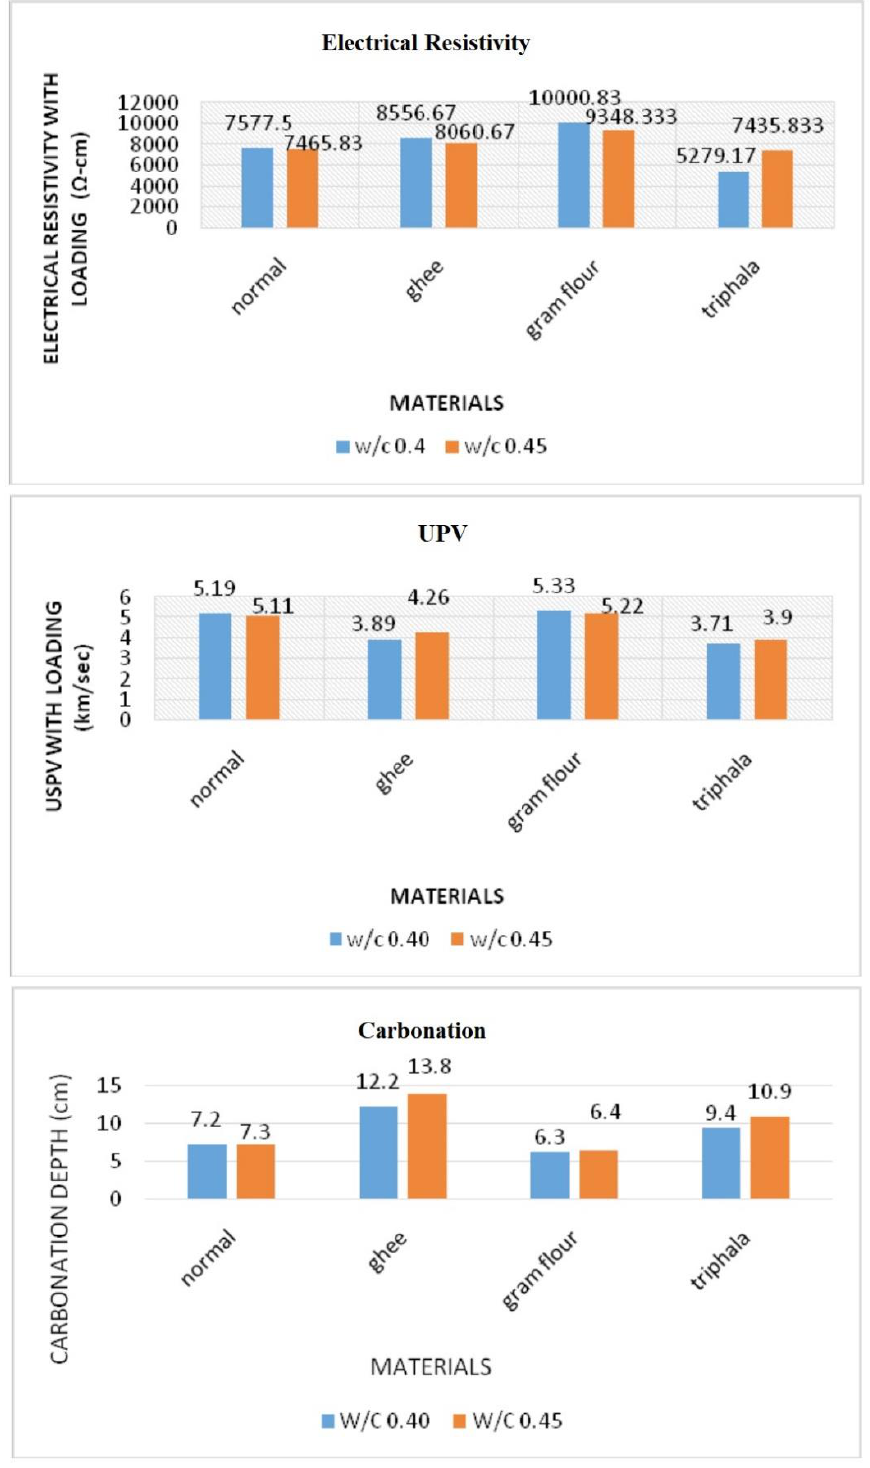
Figure 4. Test results (gram-flour, ghee and triphala) on concrete properties (Patel and Devo